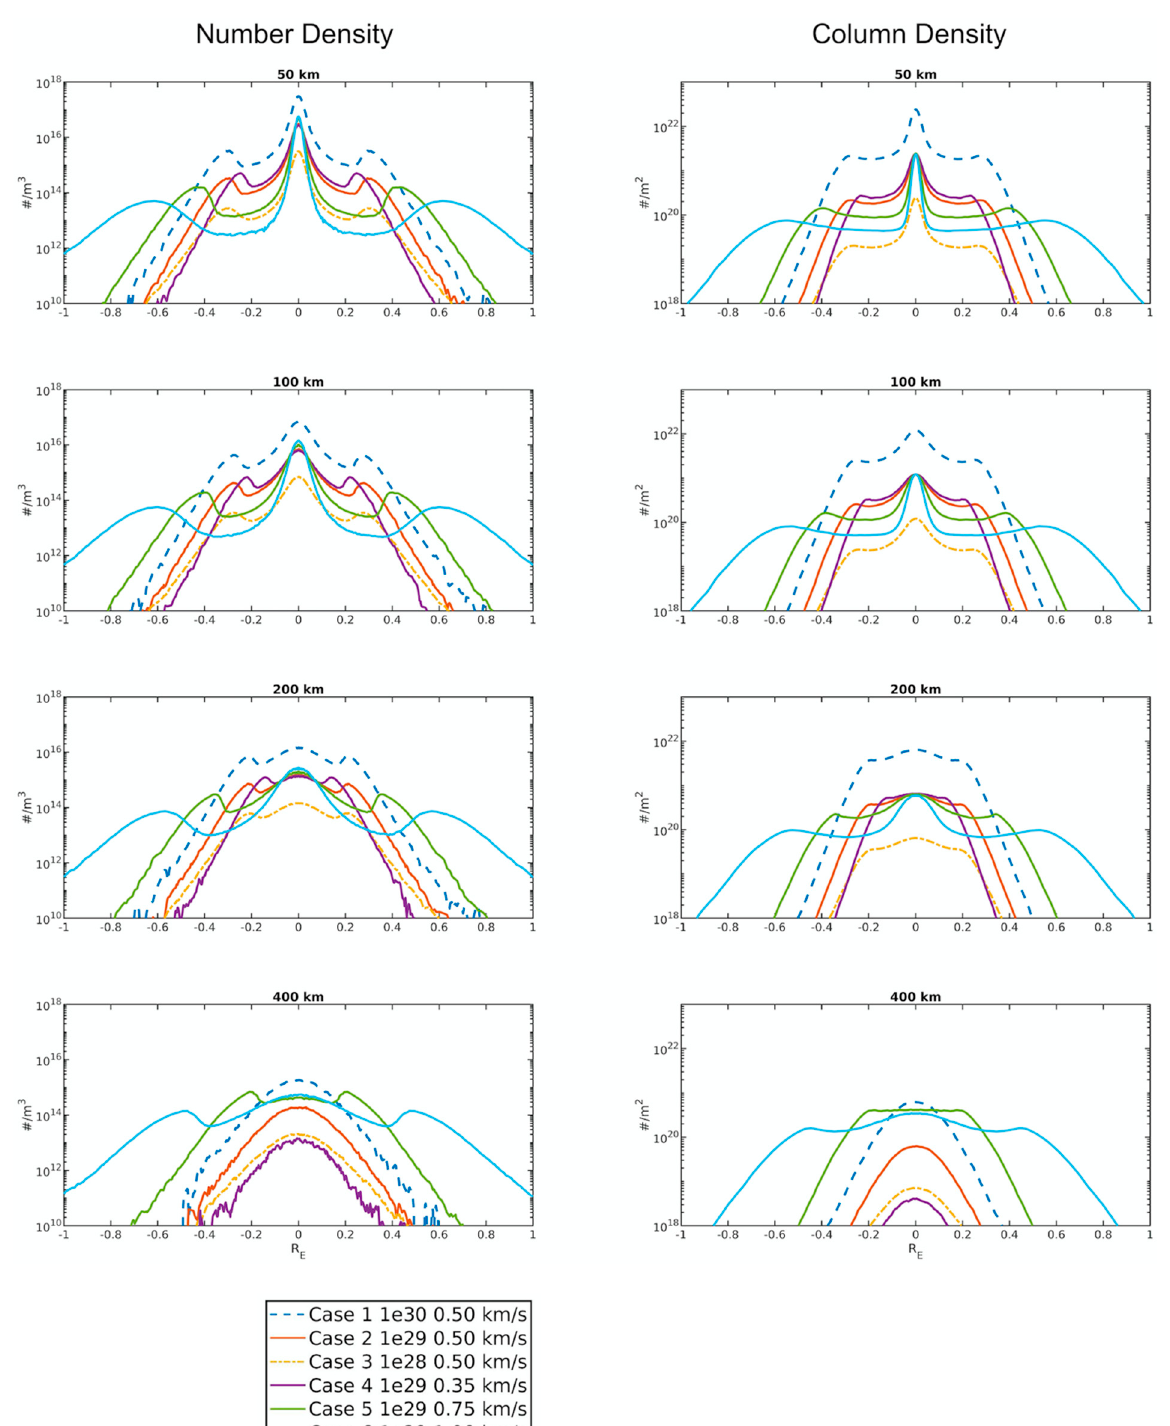
Figure 2. Column a ( Left ): Number density distribution (shown in contours with a color scale in units of # m − 3 ). The dashed, horizontal lines in case 1 represent four heights above the surface at 50, 100, 200 and 400 km. Column b ( Right ): Gas velocity distribution (shown in contour with a color scale in units of m s − 1 ). Gas flow streamlines are presented too.